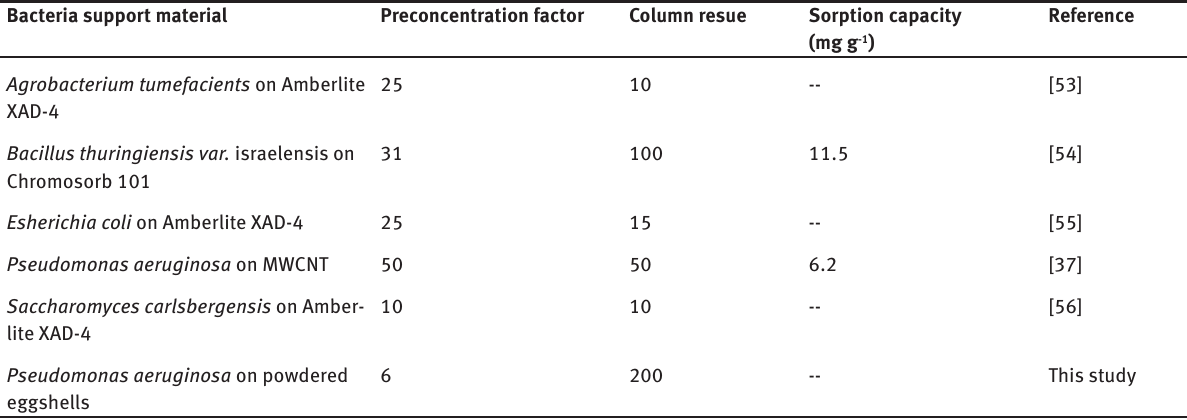
Table 3: Comparison of analytical characteristics of Cr on bacteria. Bacteria support